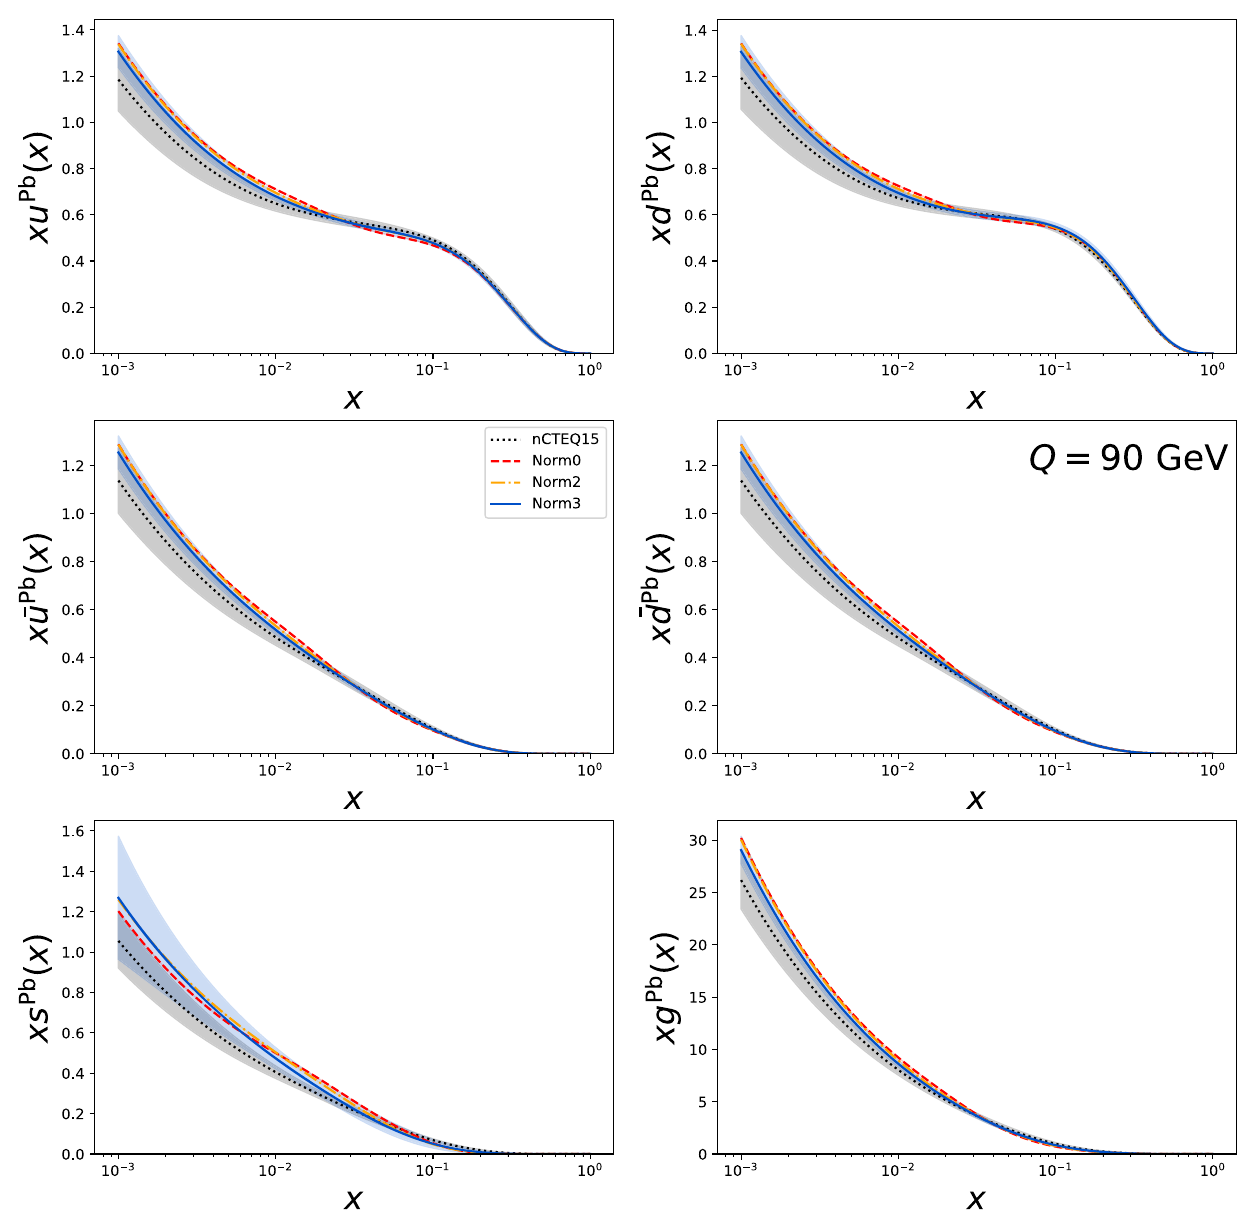
Fig. 9 The full lead (Pb) PDFs for Q = 90GeV. The uncertainty band for nCTEQ15 is shown in gray, and for Norm3 in